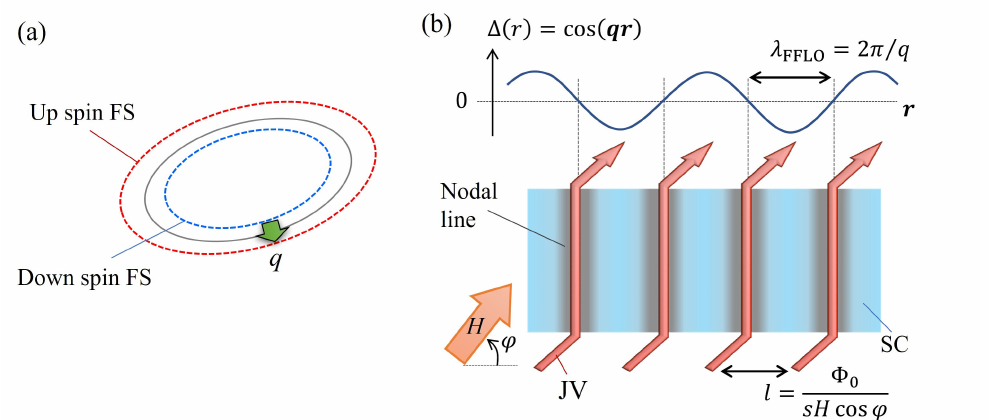
Figure 8. ( a ) Spin-polarized 2D Fermi surface in a magnetic field. Up and down Fermi surfaces are indicated by red and blue curves, respectively. ( b ) Schematic nodal line structure of a FFLO phase and JV lattice in a tilted field for the CM condition l / λ FFLO =